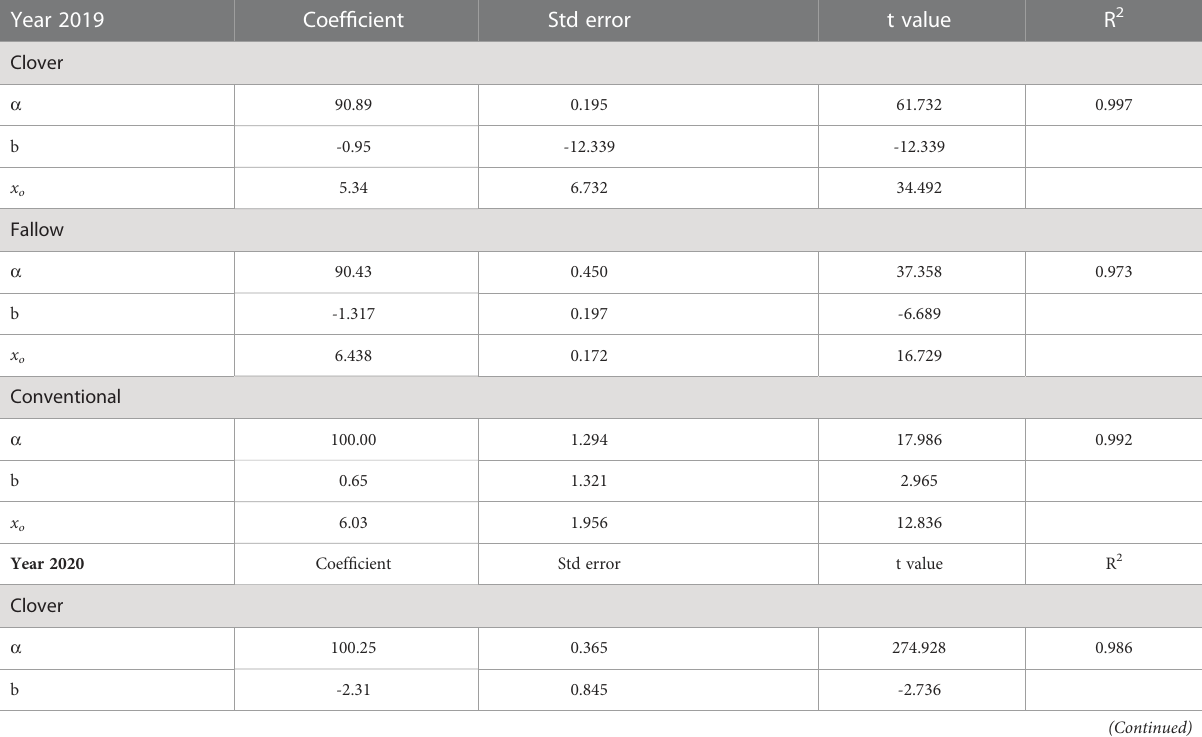
TABLE 2 Statistics of the three-parameter logistic regression model fi tted to relative corn yield to estimate the critical weedy period (CTWR) for each of the conservation tillage following a crimson clover cover crop (CT + CC), conservation tillage following winter fallow (CT + WF), and conventional tillage without a cover crop (CVT) treatment in 2019 and